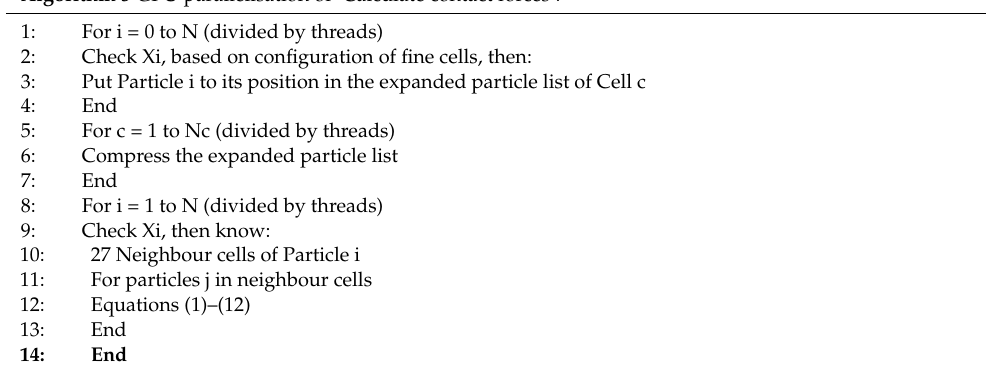
Algorithm 3 GPU parallelisation of ‘Calculate contact forces’.